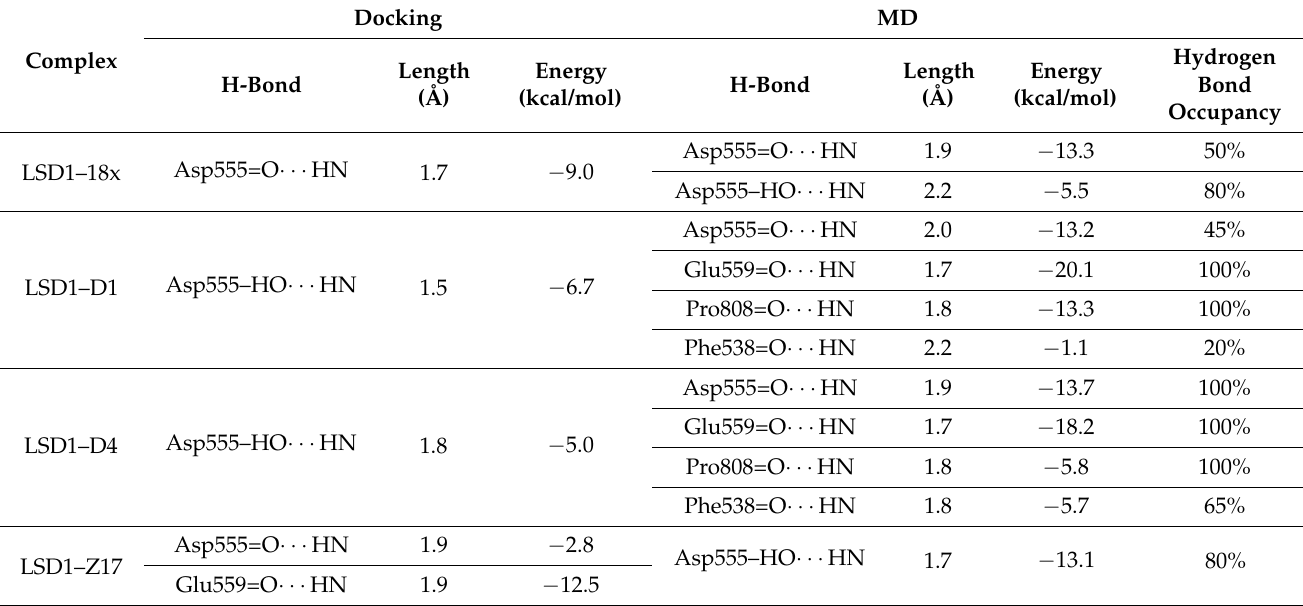
Table 5. Hydrogen bonds of each complex.